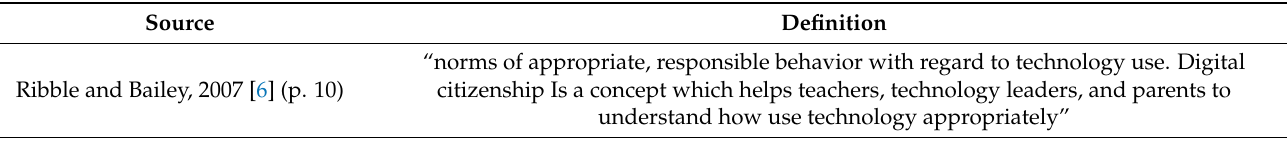
Table 1. Scales for measuring digital citizenship and psychometric